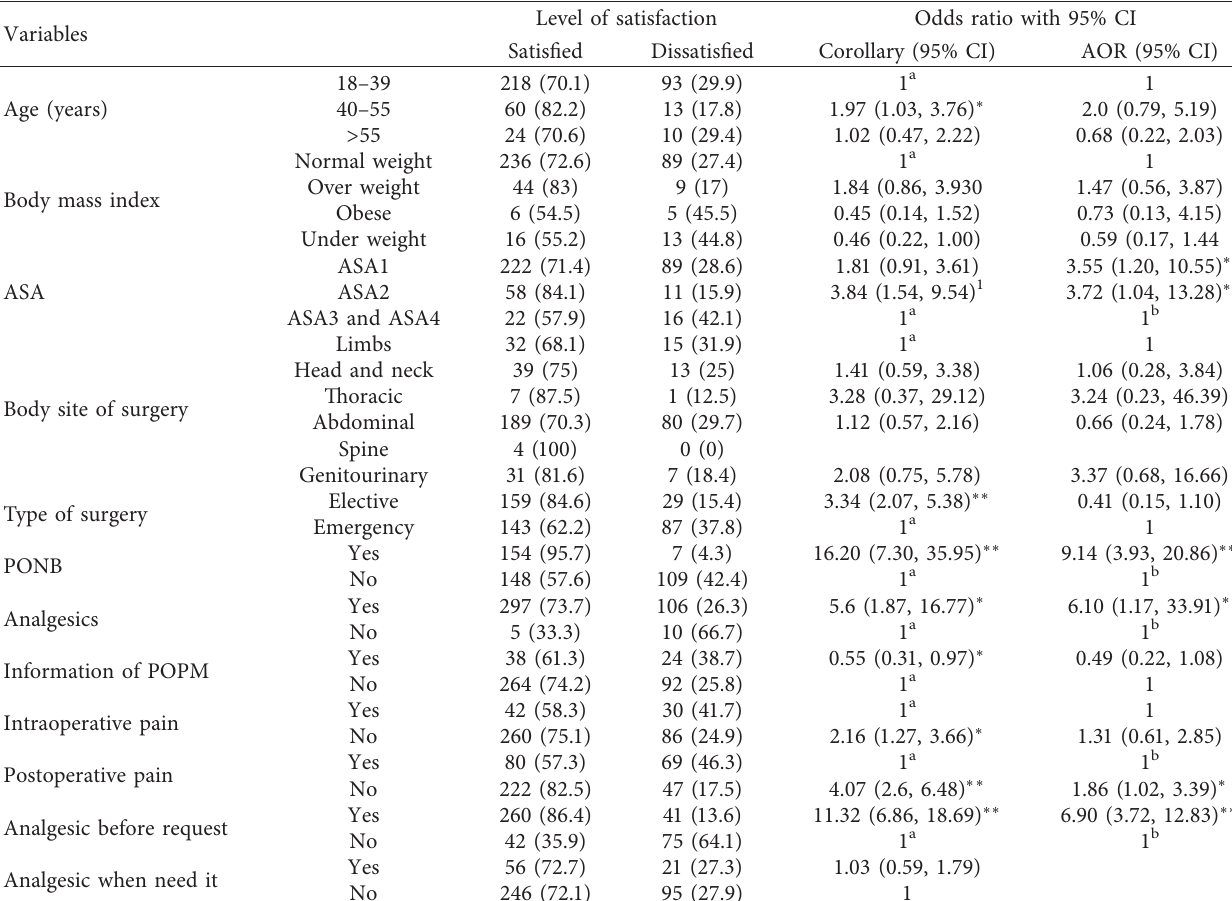
Figure 1: Level of patients’ satisfaction with subscales and overall in postoperative pain management at the University of Gondar comprehensive specialized hospital, northwest Ethiopia, 2018 ( N � 418). Table 2: As assessed 24h after surgery, bivariate and multivariate logistic regression analyses results, patients experiences in perioperative time for satisfaction of postoperative pain management, assessed at 24 hours following surgery in the University of Gondar compressive specialized hospital, northwest Ethiopia, 2018 ( N �